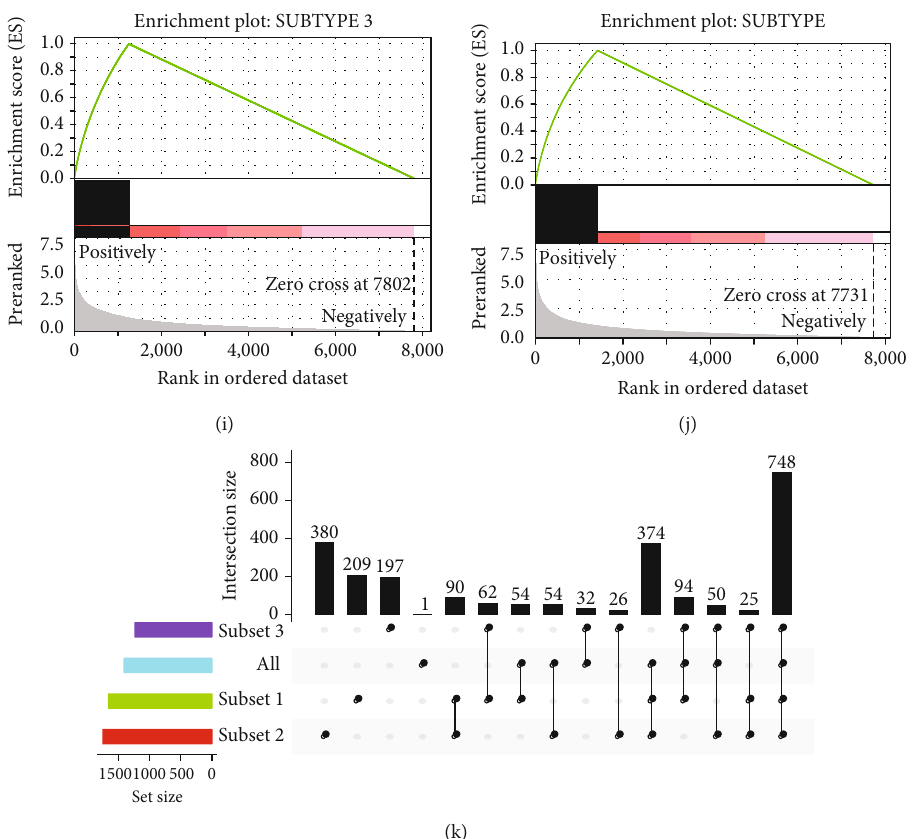
Figure 3: Identi fi cation of di ff erentially expressed in lncRNAs and PCGs of di ff erent subtypes. (a – c) Volcano map of di ff erentially expressed lncRNAs in three molecular subtypes, respectively. (d) Volcano map of di ff erentially expressed lncRNAs in all subtypes. Red means up- expression and blue means down-expression. (e) Distribution of di ff erential lncRNA and PCGs in molecular subtypes. (f) The Venn diagram of the di ff erential lncRNA and disease-related lncRNA. P < 0 : 033 . (g – j) GSEA analysis of three molecular subtypes as the rank according to the di ff erence multiple. (k) The intersection of di ff erentially expressed lncRNAs in three molecular